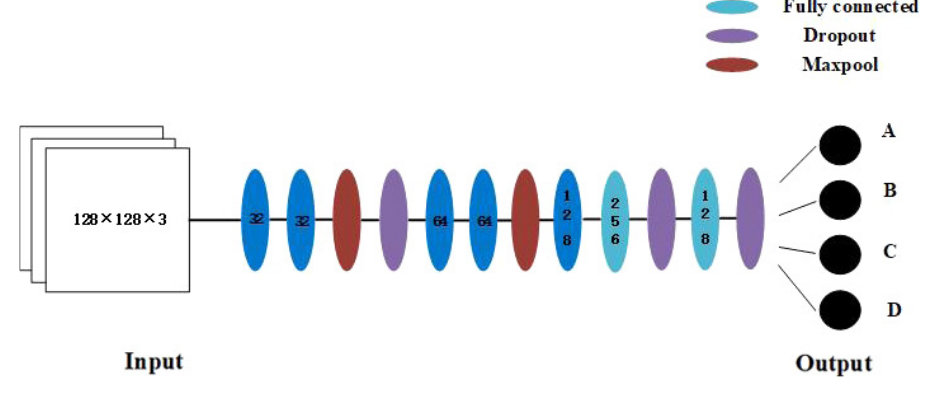
Fig. 2. The structure of CNN.